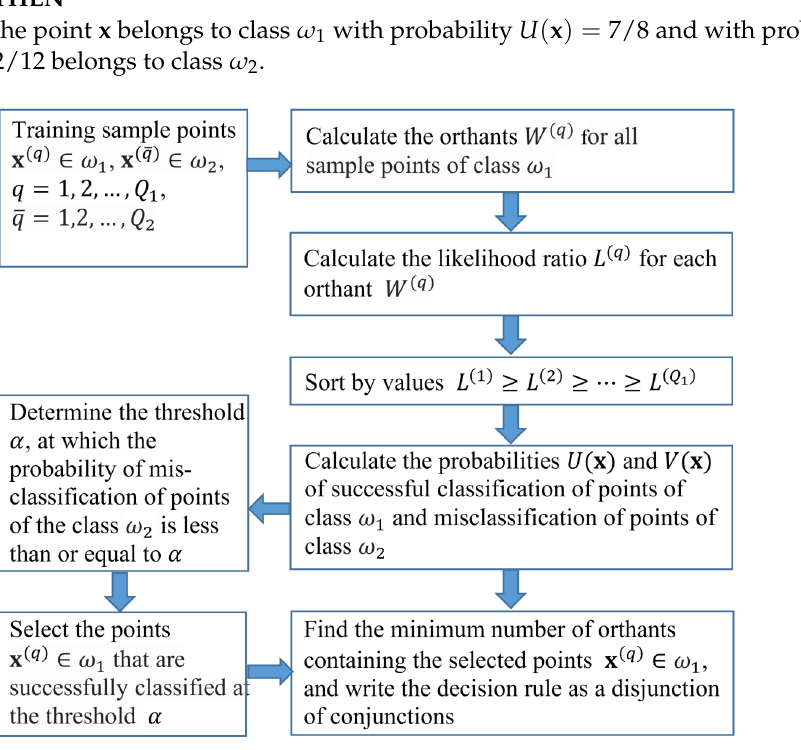
Figure 1. Block diagram of the algorithm of the method of monotonic functions.